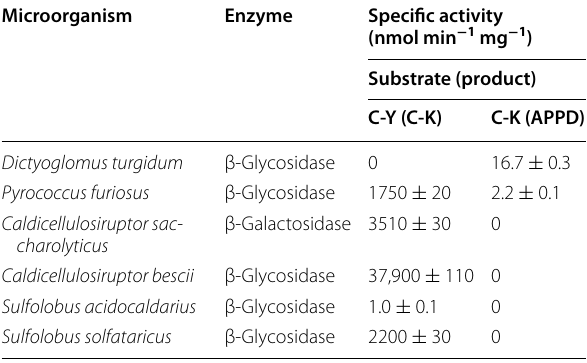
Table 1 Specific activity of glycoside hydrolases from ther- mophilic bacteria towards ginsenosides C-Y and C-K